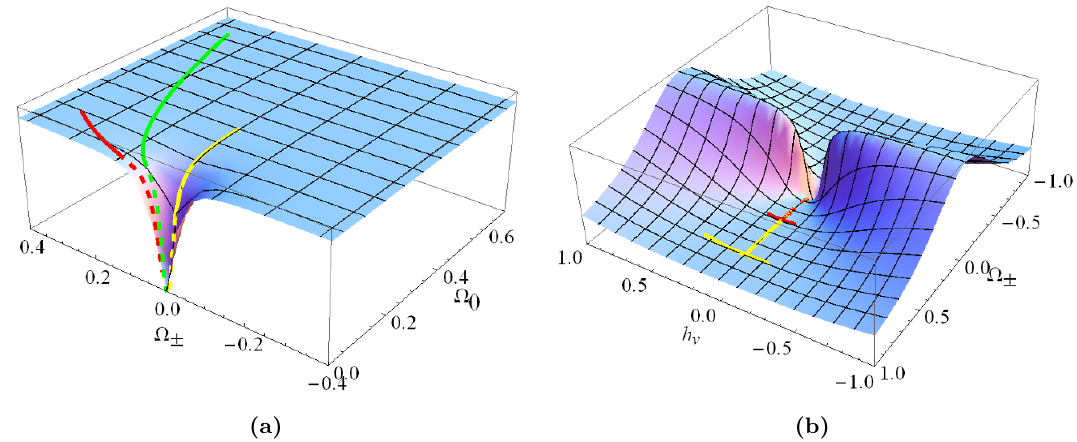
Figure 2. Parametric plots of the (cid:12)elds’ evolution superimposed on the Einstein-frame potential for A parameter sets, plot (a), and B parameter sets, plot (b), see the parameter sets in table 1. The trajectories shown here have the initial condition (in units of M Pl ): (a) (cid:30) 5 =0.1 (red line); (cid:30) 1 (cid:30) 2 =0.24, (cid:30) 3 =0.3, (cid:30) 4 0 0 0 (cid:30) 2 =0.26, (cid:30) 3 =0.5, (cid:30) 4 =0.6 (green line); (b) (cid:30) 3 0 0 0 (cid:30) 1 =0.4, (cid:30) 2 =0.6, (cid:30) 5 =0.3 (yellow line). The dashed lines correspond to the in(cid:13)ationary stage when 0 0 0 0 (cid:20) N (cid:3) (cid:20) e